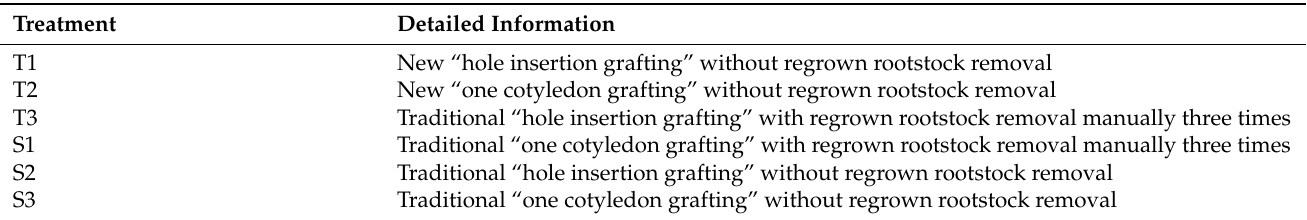
Table 1. Abbreviations and detailed information of treatments in this study. Treatment Detailed